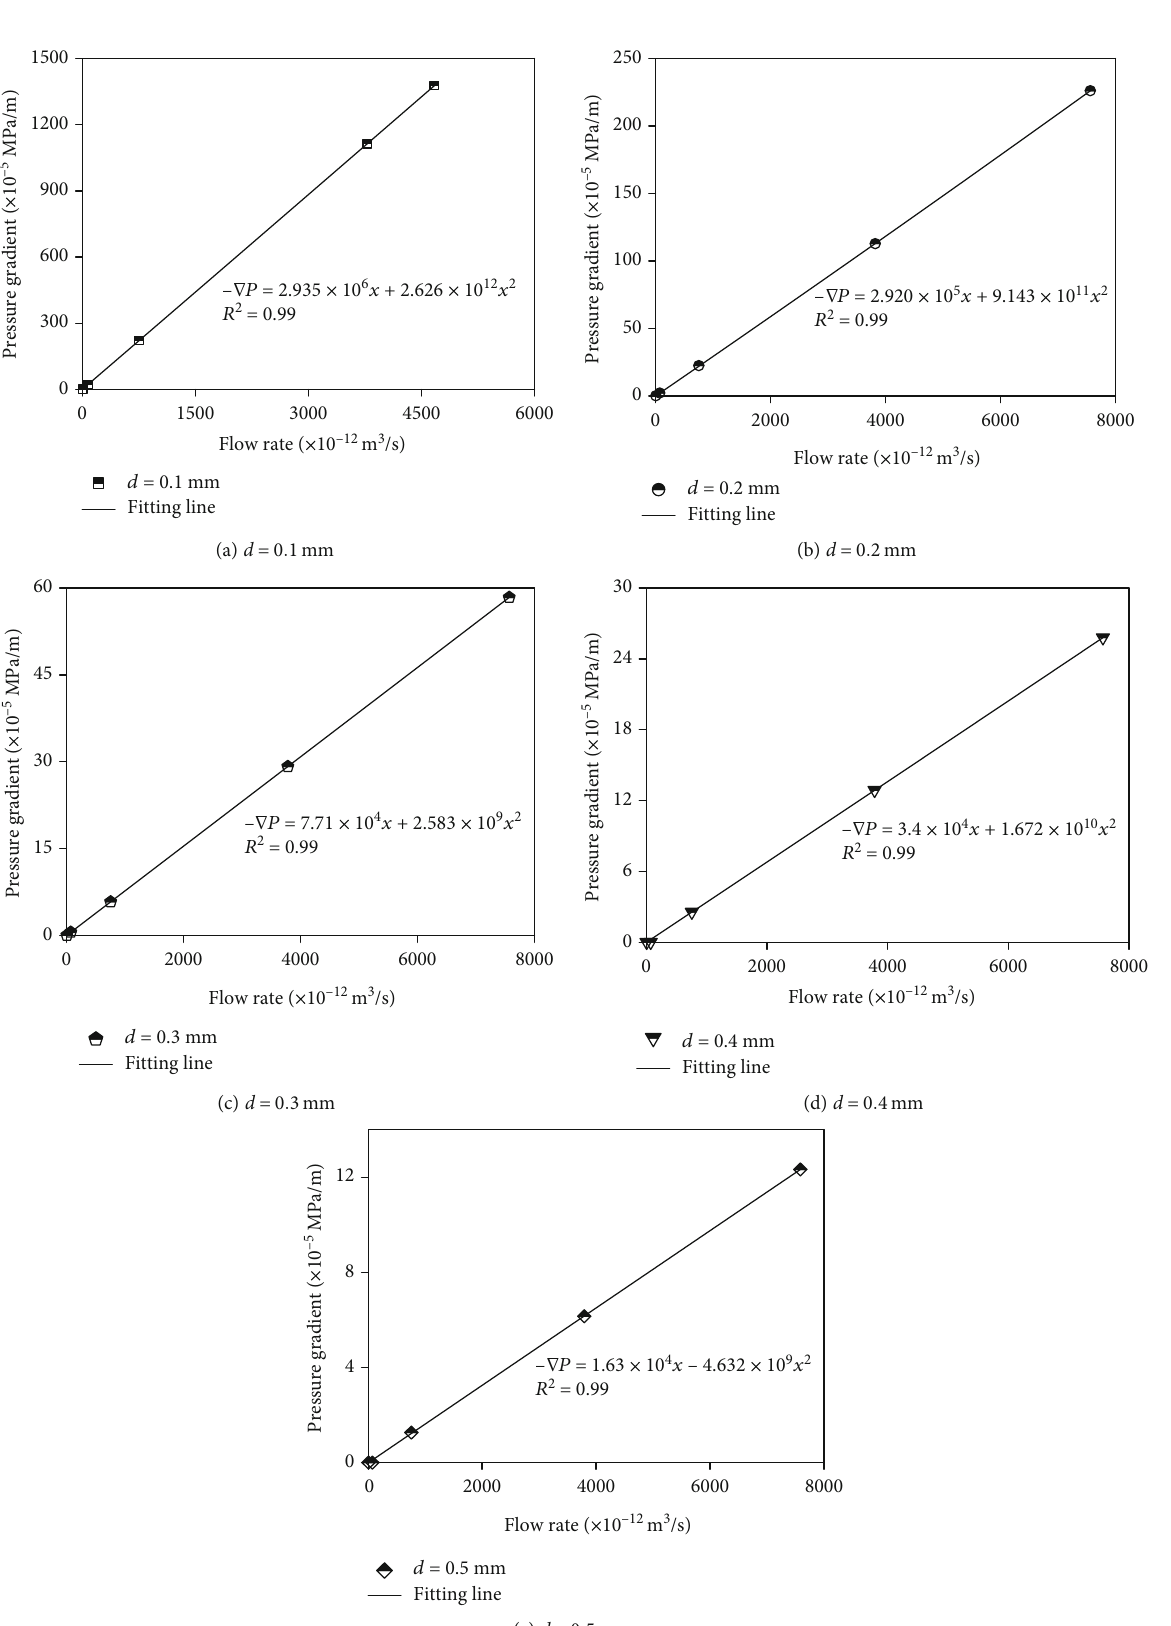
Figure 5: Volume fl ow rate versus pressure gradient